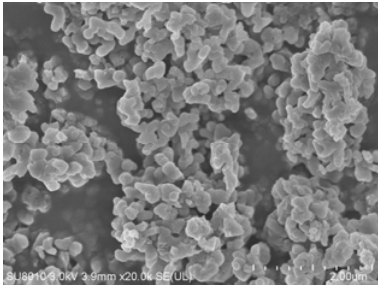
Figure 10. SEM images of M ‐ NEPCMs after thermal cycling 300 times.